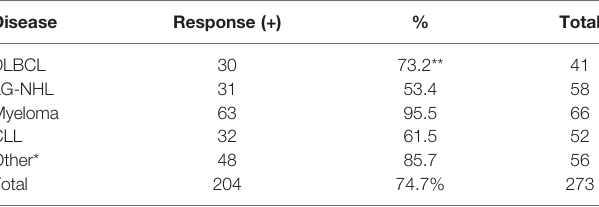
*Other: Hodgkin ’ s lymphoma, peripheral T cell lymphoma (PTCL), large granular lymphocytosis (LGL), lymphoproliferative disease, cutaneous T cell lymphoma (CTCL), Post-transplant lymphoproliferative disease (PTLD), Castleman disease etc. **The overall difference in response rate is signi fi cant (p<0.001), showing differences in response rates between disease groups.